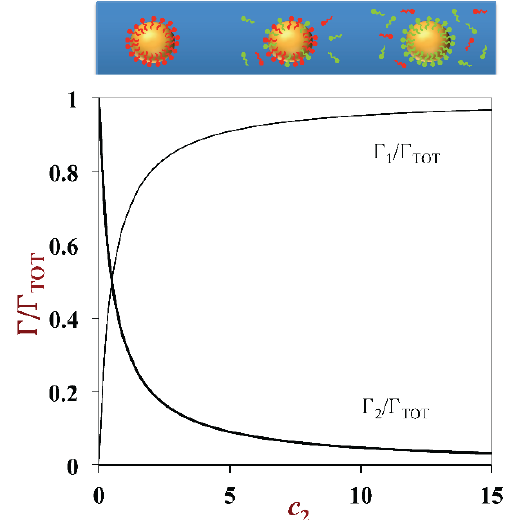
Figure 4. The interfacial composition of the droplets in an oil-in-water emulsion may be altered after homogenization by surfactant displacement methods.